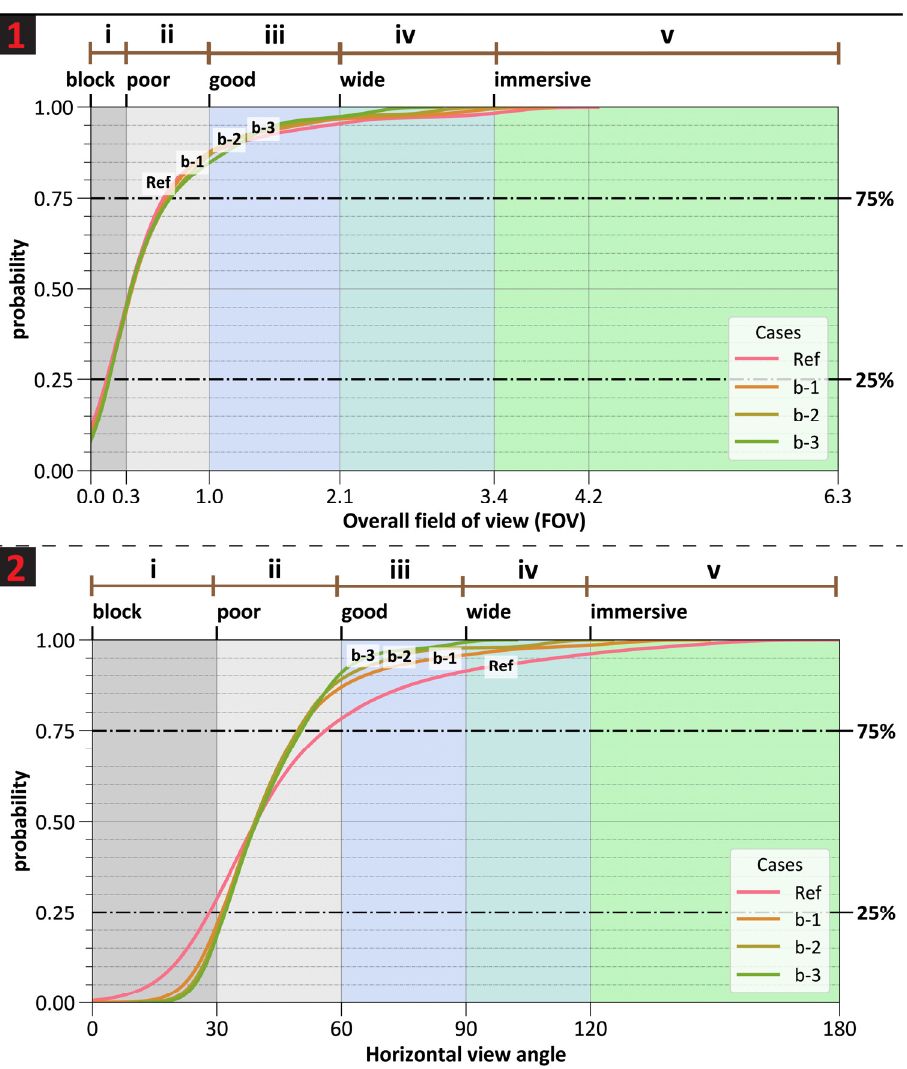
Figure 12. Impacts of dividing to multiple windows on the cumulative probabilities of overall and horizontal FOVs for the case studies of